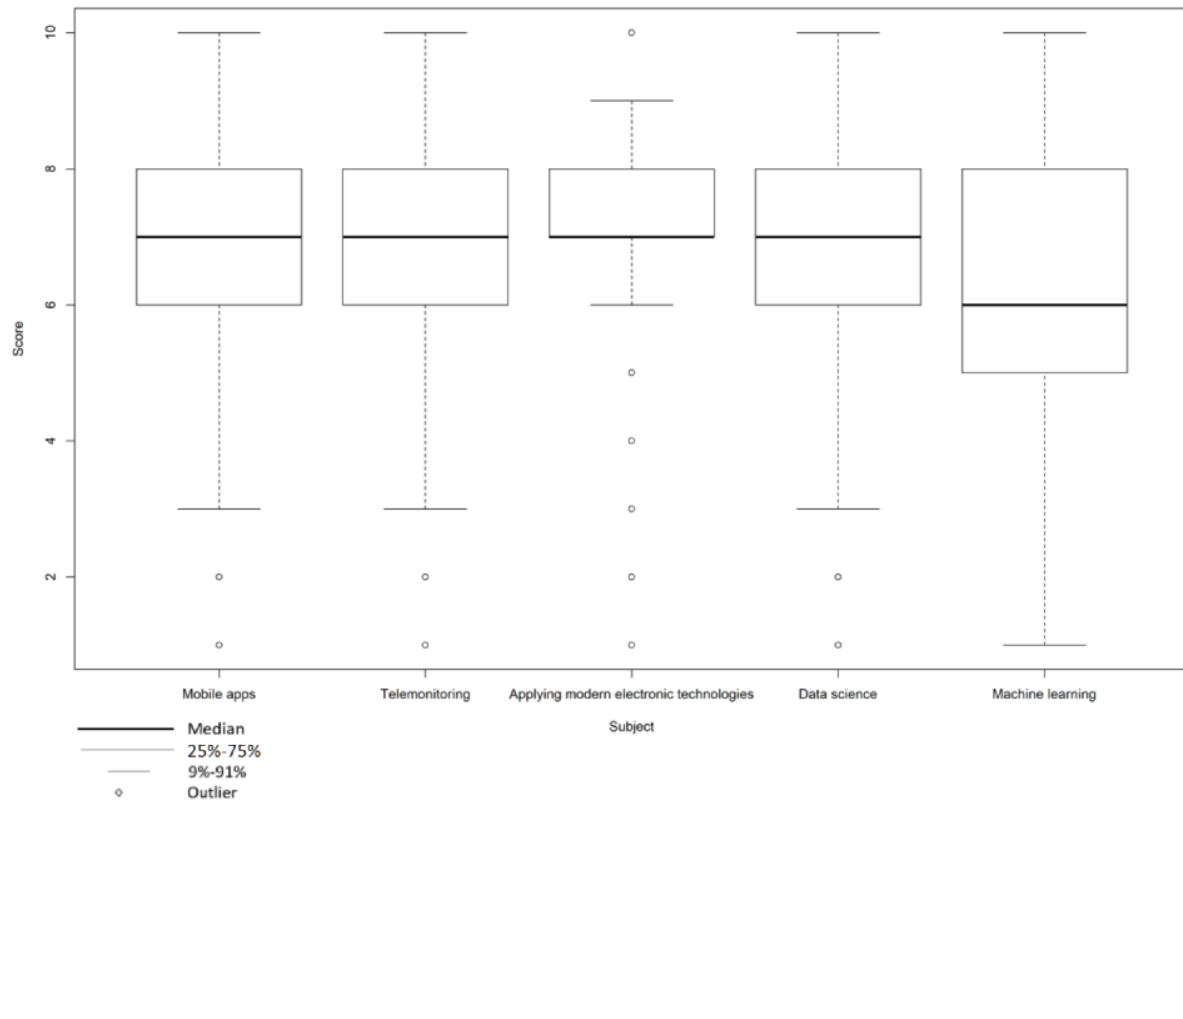
Figure 1. Students' attitudes toward given topics in the medical curriculum (N=303). Scores range from 1 (fully disagree) to 10 (fully